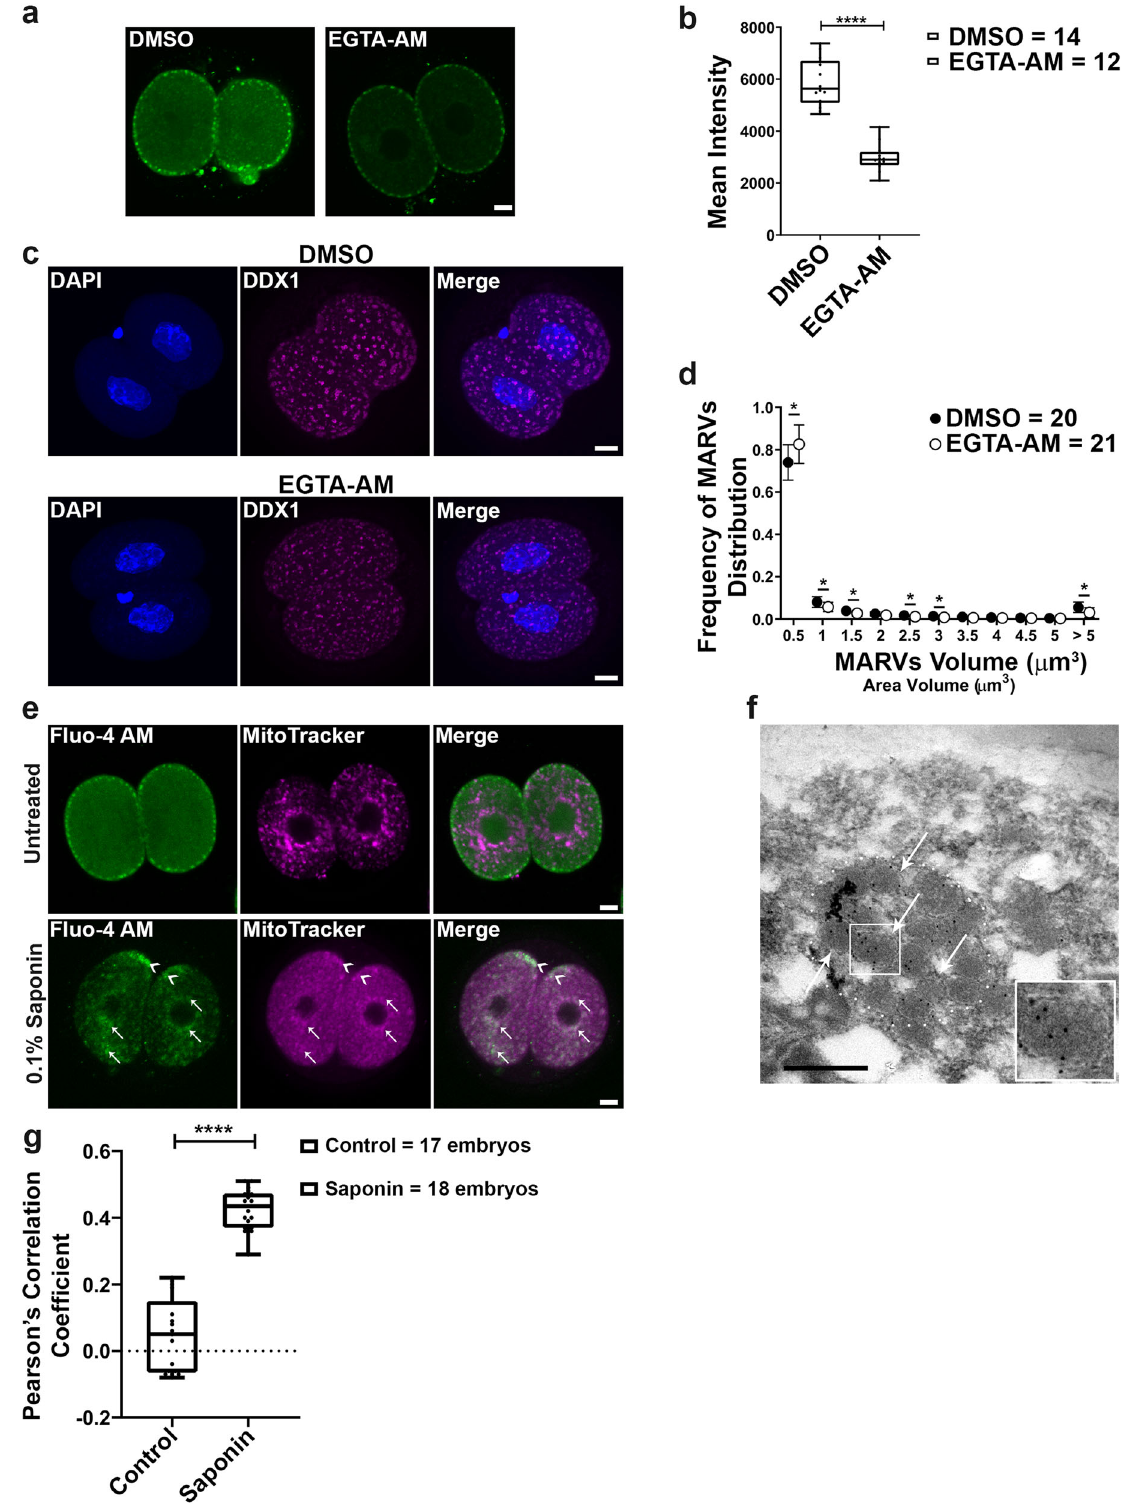
Ddx1 − / − embryos have high levels of mitochondrial activity . We next cultured 1-cell embryos from Ddx1 + / − intercrosses to address the effect of Ddx1 knockout on Ca 2 + distribution and embryonic development. Cultured 1-cell embryos from Ddx1 + / + crosses were used for comparison. Ideally, the embryos from Ddx1 + / − intercrosses should be imaged at the 2- to 4-cell stages and then cultured so that they could later be categorised